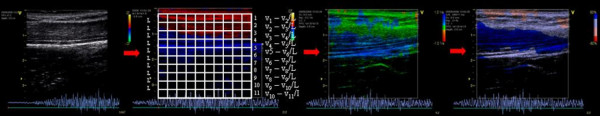
The principle of calculations of the superimposed colour-coded images; see text for explanations. The images above illustrate the calculating principle providing data to be presented in colour-coded images presenting regional strain rate and strain (see text for detailed explanations).